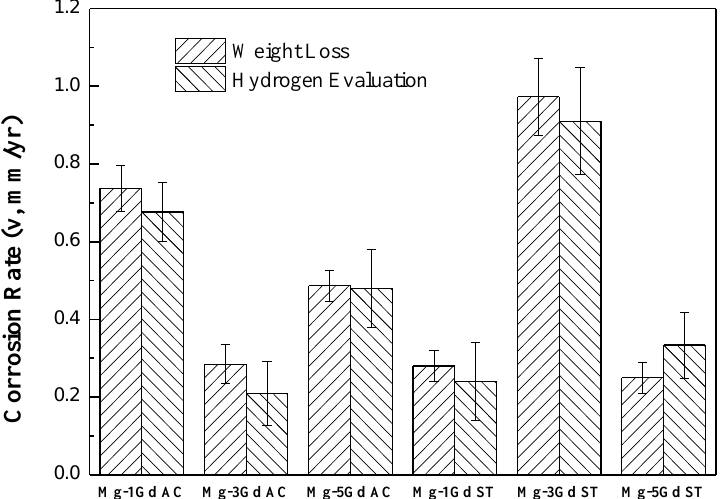
Figure 8. Corrosion rates of the as-cast, solution-treated Mg-xGd alloys in Hanks’ solution for 5 days at 37 °C.